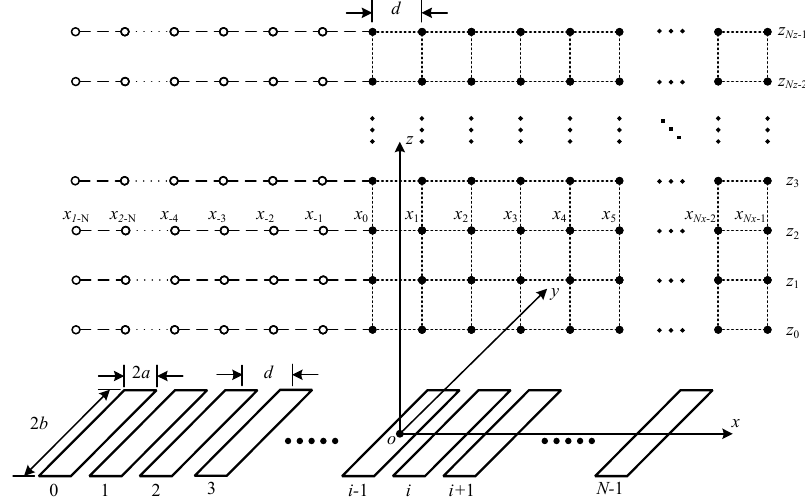
Figure 5. Geometry of the discretized field points and auxiliary points for linear phased array